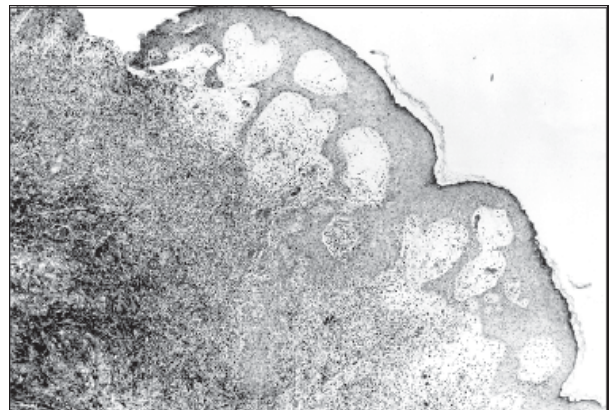
Figure2) Hematoxylinandeosinstainedsection.Multinucleatedgiant cells and keratinocytes with intranuclear inclusions (arrows) diagnos- tic of herpes infection are present in an inflammatory